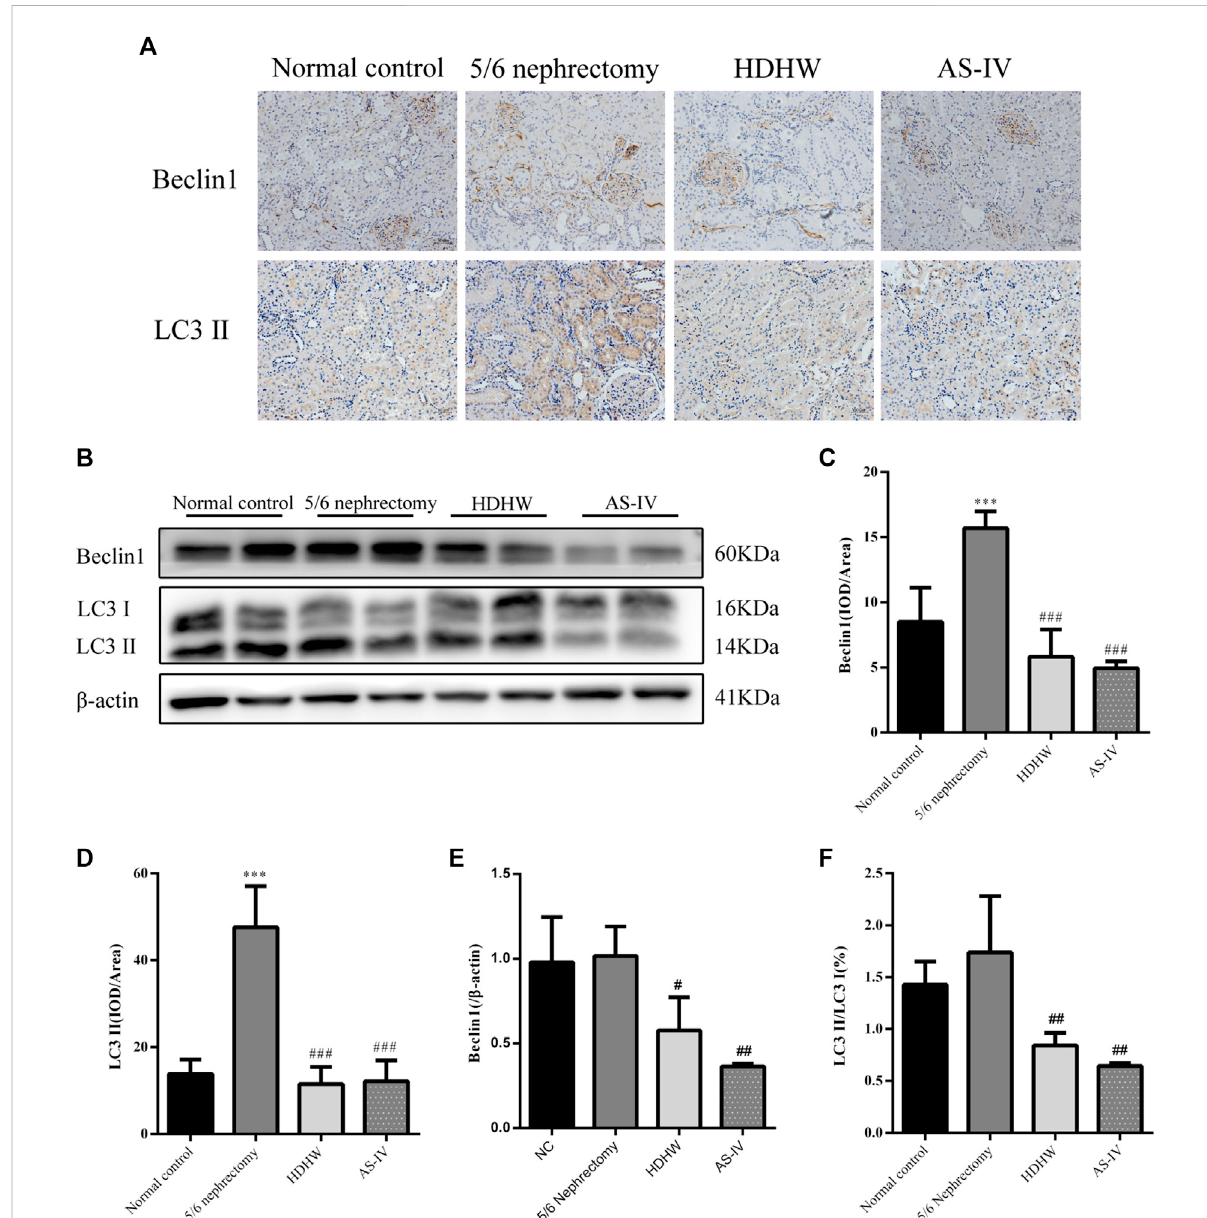
FIGURE 4 Effects of HeidihuangWan (HDHW) on autophagy. (A) Immunohistochemical staining analysis of Beclin1, LC3II expression. (B) Western Blotting to detect the protein levels of Beclin1, LC3II. (C,D) Image-Pro Plus software was used to statistically analyze the immunohistochemical staining results of Beclin1 and LC3II, respectively. (E,F) Protein concentration analysis. Data are presented as mean ± SD, n = 6. The data are expressed as *** p < 0.001: compared with normal control group; # p < 0.05, ## p < 0.01, ### p < 0.001: compared with 5/6 nephrectomy group,